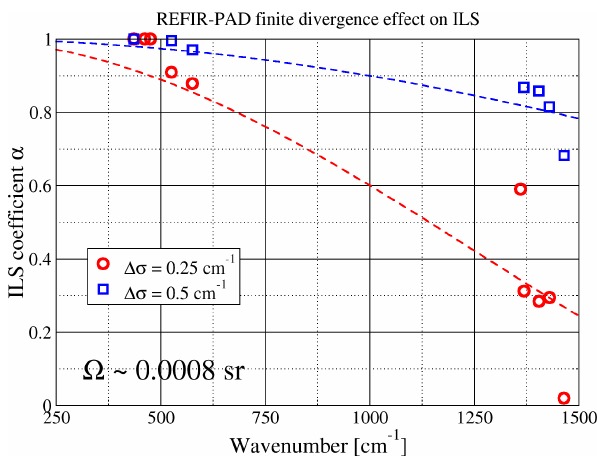
Figure 5. REFIR-PAD instrumental line shape coefficient obtained through analysis of measured spectra for 0.25 and 0.5cm − 1 nom- inal resolution. Continuous lines show the sinc (z max σ 0 (cid:127)/ 2 ) theo- retical